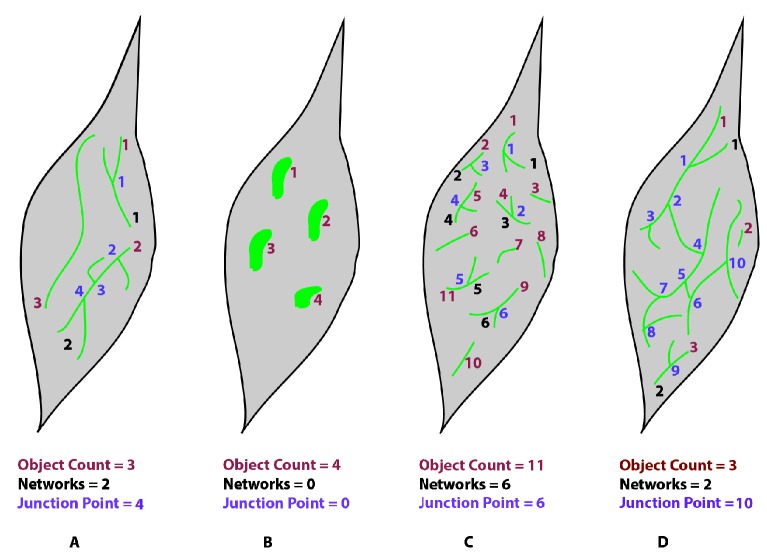
Examples of networks analyzed by MitoMAPR.Using Networks (N) and Junction Point (JP) values, it is possible to estimate the degree of complexity of the mitochondrial network. As illustrated the four cells (A–D) have their mitochondria marked out in green. The mitochondrial objects are counted in orange (Object Counts), Networks in black and Junction Points (JP) are marked out in purple. While panel A has three objects, it has only two networks, with one Junction Point in one network and three in the other. Panel B has no networks since none of the objects have any junction points. Conversely, panel D has three distinct objects and two networks. The larger network has 9 Junction points while the smaller one possesses a single junction point. A higher number of junction points indicates a greater degree of branching and larger network spread. Building on these attributes, compared to samples A-C, sample D exhibits a higher mitochondrial complexity and interconnectivity.